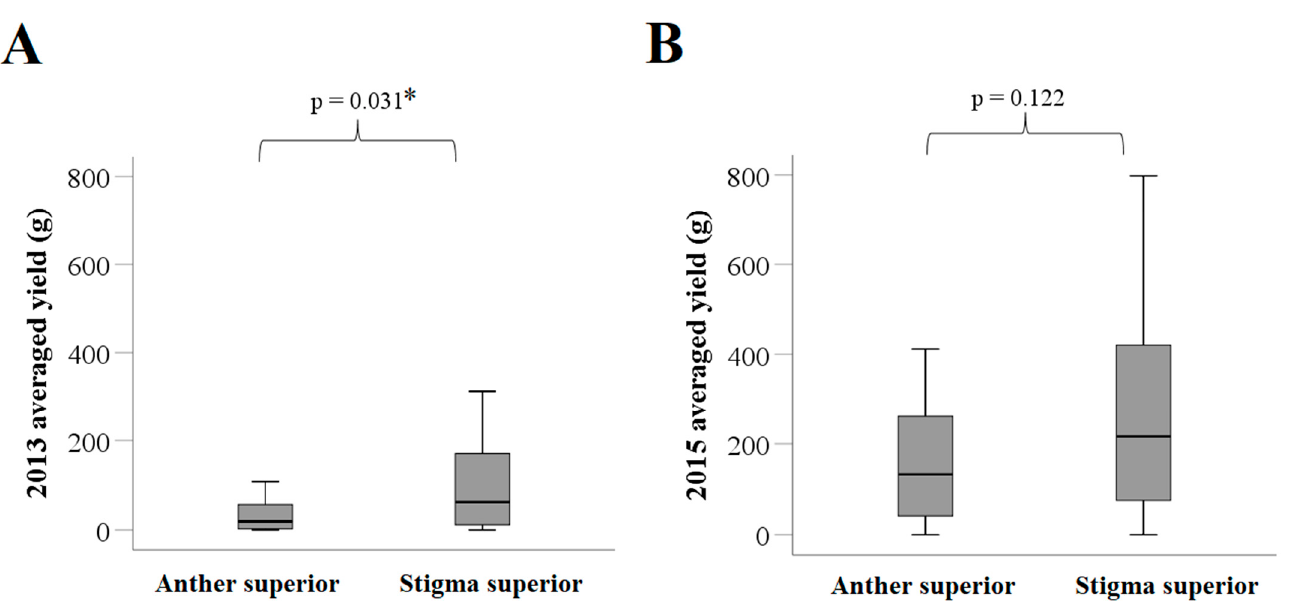
Table 3. Correlations of yield versus phenotypic traits by group on the average yield of tea plants at two years.